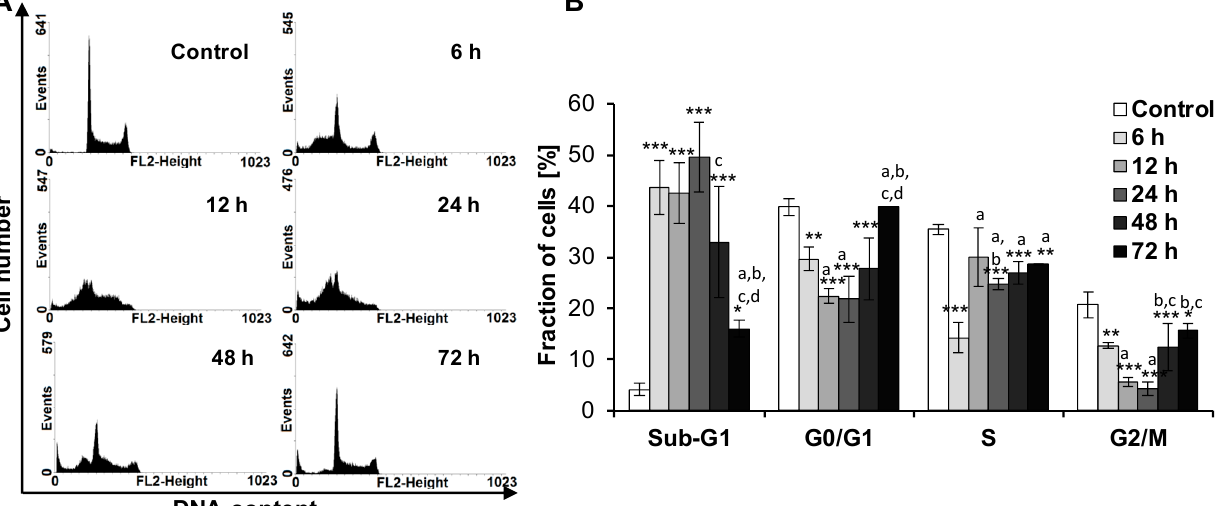
Figure 2. Effect of piceatannol on the cell cycle distribution of HL-60 cells. Cells were incubated with piceatannol (IC 90 = 14 µM) for 6, 12, 24, 48, and 72 h (PI staining). ( A ) Time-course changes in the cell cycle distribution of piceatannol-treated HL-60 cells. Data correspond to one representative experiment. Similar results were obtained in a total of three independent experiments in duplicates. ( B ) Percentage of cells of the sub-G1 fraction and phases of the cell cycle. Data are presented as means ± SD of three independent experiments in duplicates. * p < 0.05, ** p < 0.01, *** p < 0.001, statistically significant differences compared to control (untreated cells); a p < 0.05, statistically significant differences compared to cells treated with piceatannol for 6 h; b p < 0.05, compared to cells treated with piceatannol for 12 h; c p < 0.05, compared to cells treated with piceatannol for 24 h; d p < 0.05, compared to cells treated with piceatannol for 48 h (One-way ANOVA, Tukey’s post hoc analysis).